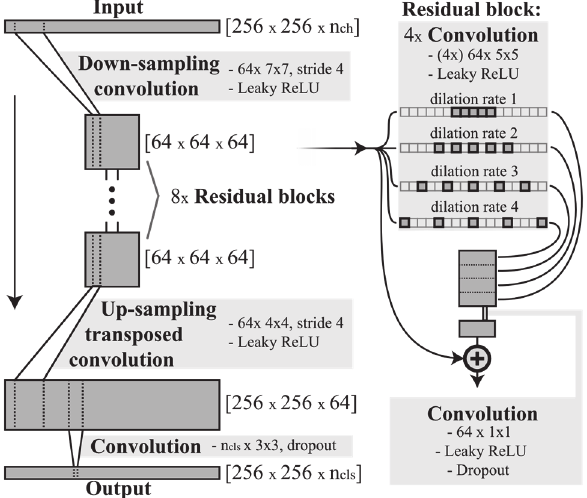
Figure 1: Proposed FCN